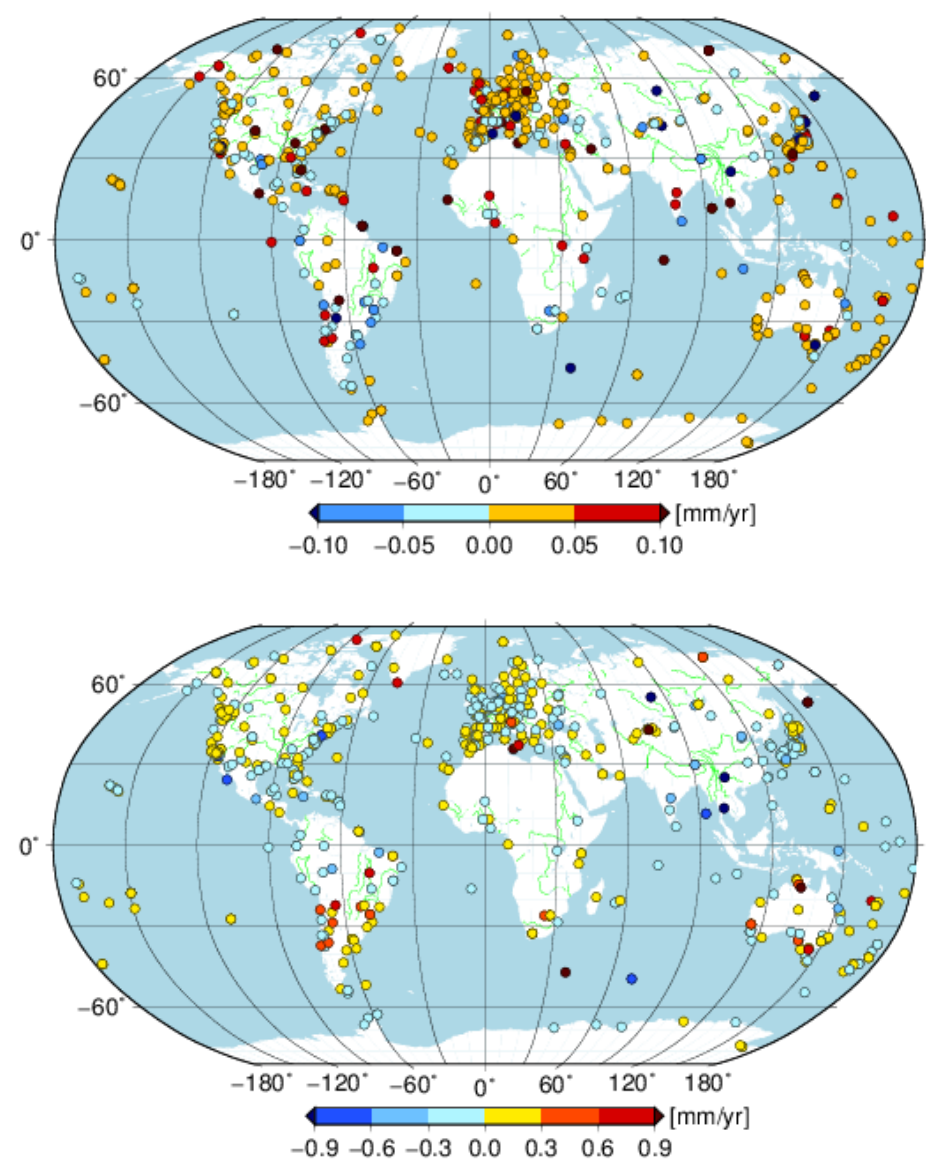
Figure 10. Velocity difference between solution cova_tr_s0 and cova_tr_s2 for east ( top panel ); north ( middle panel ) and vertical ( bottom panel ) component.